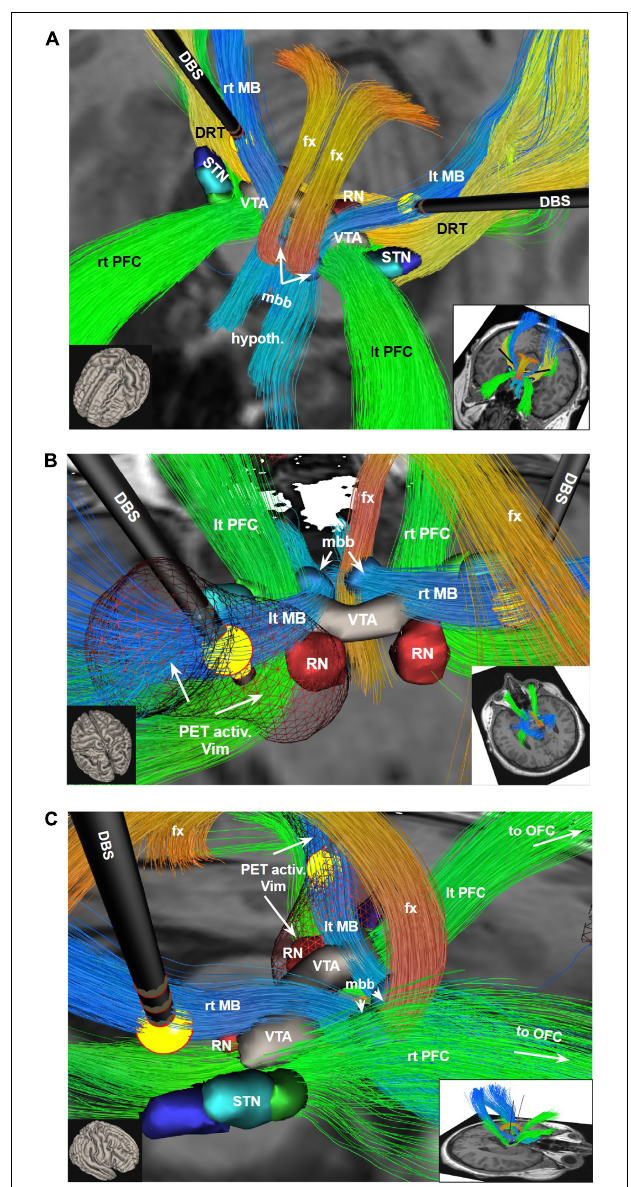
FIGURE 3 | Bilateral DBS electrodes perfectly hit MB bundles just medial to the DRT. The bilateral stimulation effectively reduces tremor ( via DRT, not shown) while at the same time modulating the limiter pathway (MB); (A) view from anterior and upper left; (B) view from posterior and upper left. PET activation surrounding the left DBS electrode extends downward into the VTA and also encroaches on the PFC pathway (in PET imaging, Figure 1 , leading to ICa/NAC activation) . (C) View from right. To understand the relationship of the stimulation electrodes and the white matter geometry we show here bundle specific tractograms (based on normative connectome data from HCP) in the native space of the considered case. Additionally, deep GM structures are shown, which are partly taken from atlases, but were also manually drawn. DBS, deep brain stimulation electrode with volume of tissue activated in yellow; DRT, dentato-rubro-thalamic bundle; fx, fornix; hypoth., hypothalamus; lt, left; MB, mamillary body branch of motorMFB; mbb, mamillary body; OFC, orbitofrontal cortex; PET activ., PET activation, PFC, prefrontal cortex branch of motorMFB, RN, red nucleus; rt, right; STN, subthalamic nucleus; VTA, ventral tegmental